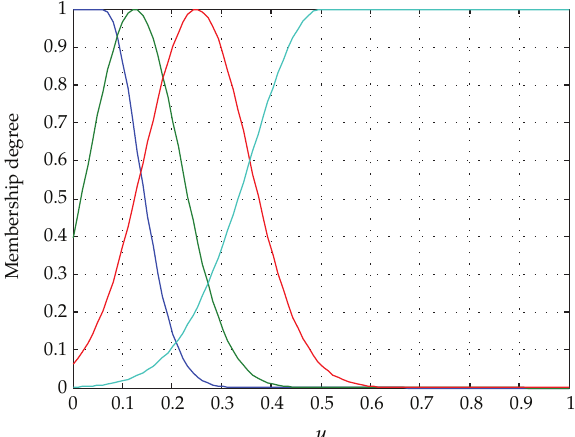
Figure 5: Membership degree curves of u i .